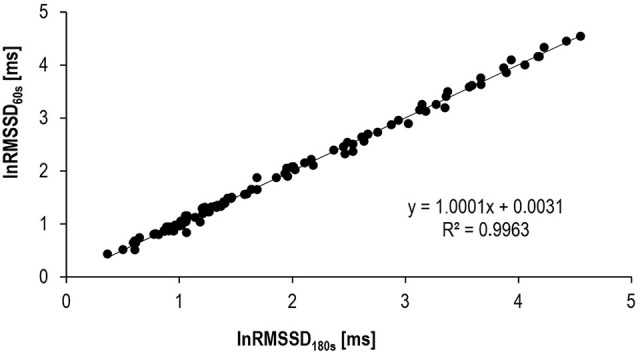
Agreement between lnRMSSD60s and traditional lnRMSSD180s.